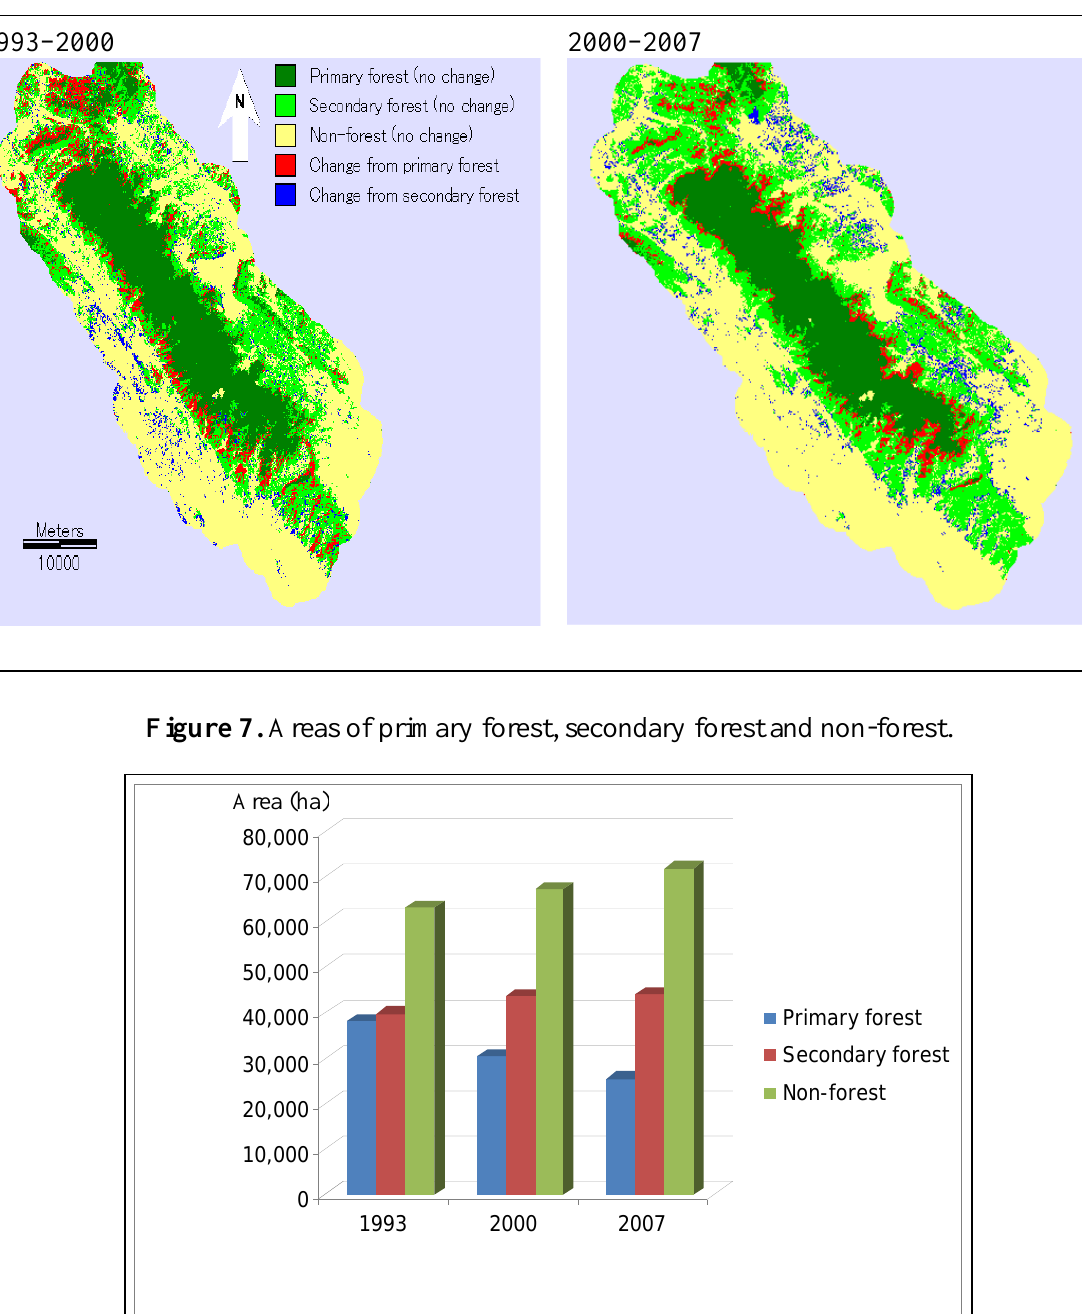
Figure 6. Forest persistence and change for the periods of 1993–2000 and 2000–2007.